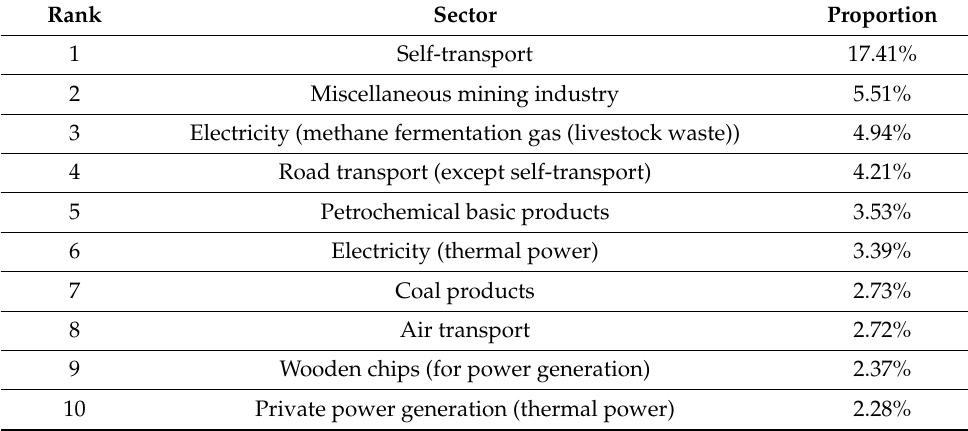
Table 3. Proportion of energy-related taxes in price in 2015 (top 10